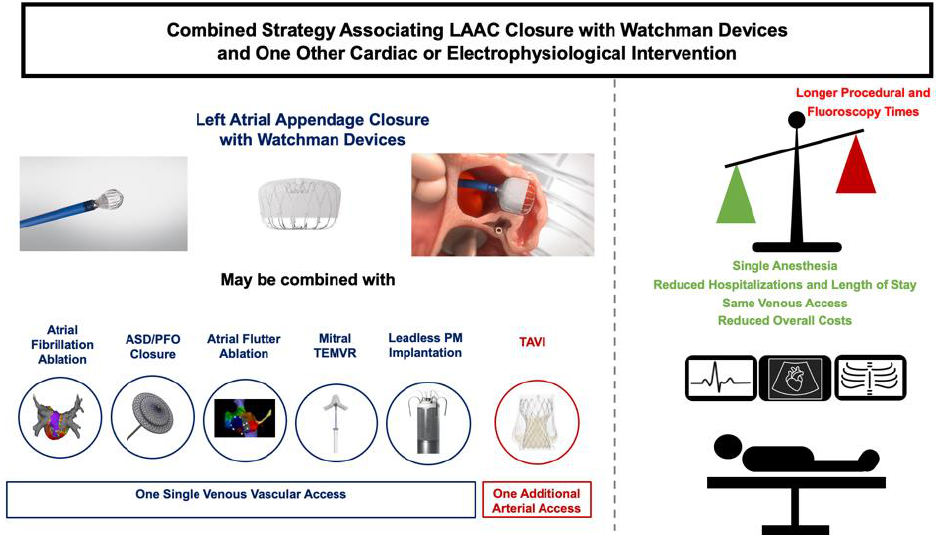
Figure 1. Benefits and limitations of the combined strategy during LAAC. Image provided